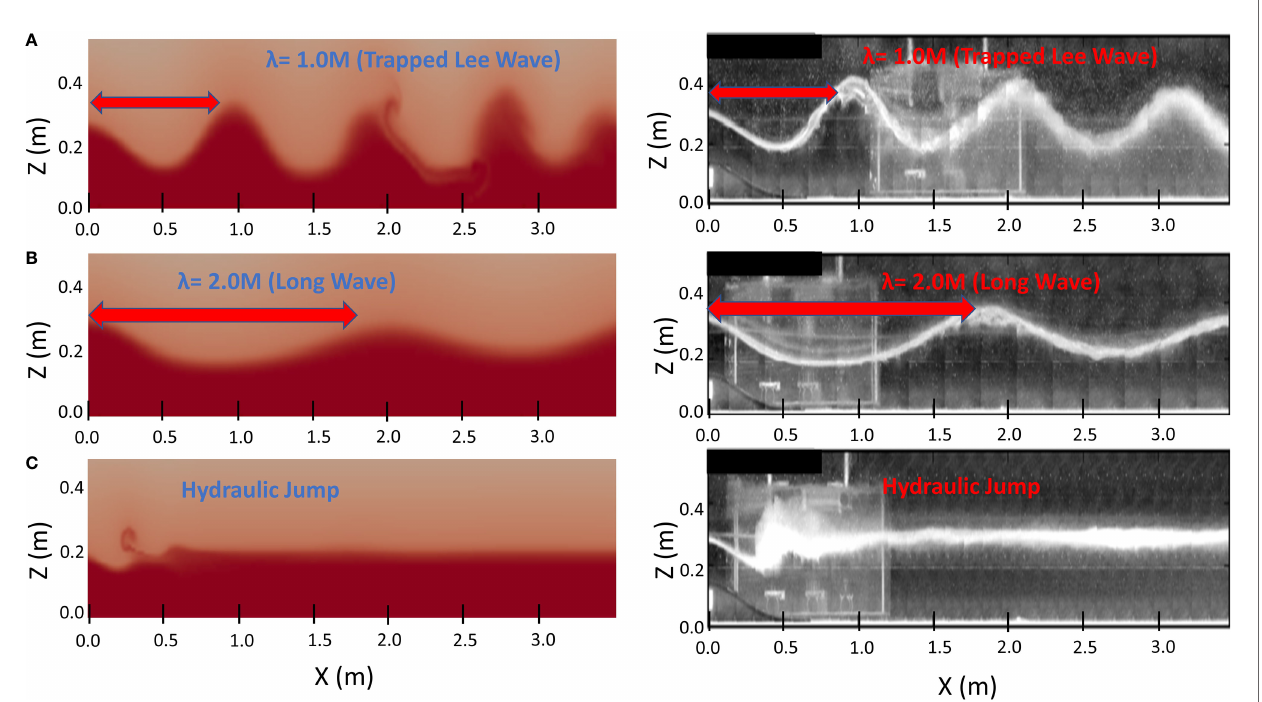
FIGURE 2 | The numerical model is validated with water tank experiments (Stiperski et al., 2017) in the strati fi ed fl ow over a two dimensional Gaussian-shaped obstacle in a water fl ume in which the given salinity controlled the fl ow strati fi cation. Model simulations (the left panels) show that the numerical model is able to reproduce the horizontal and vertical scales of (A) trapped lee waves, (B) long waves, and (C) hydraulic jump observed in the laboratory experiment (the right